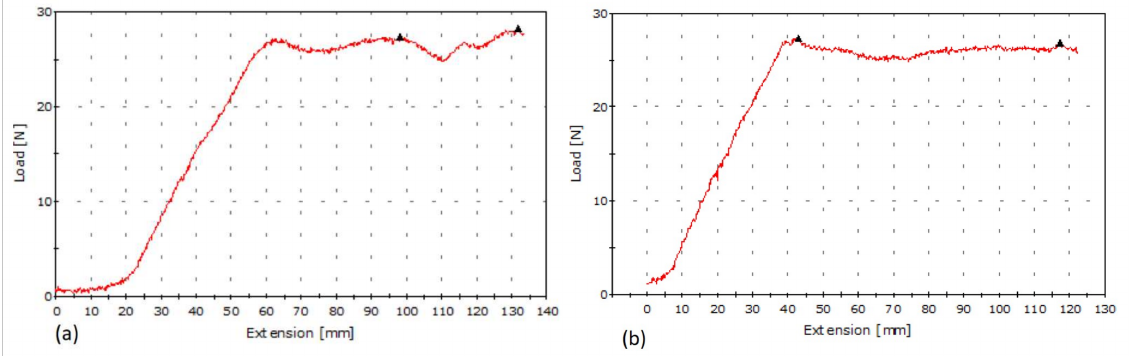
Figure 5. ( a ) TS02 disc test outcome, ( b ) TS10 disc test